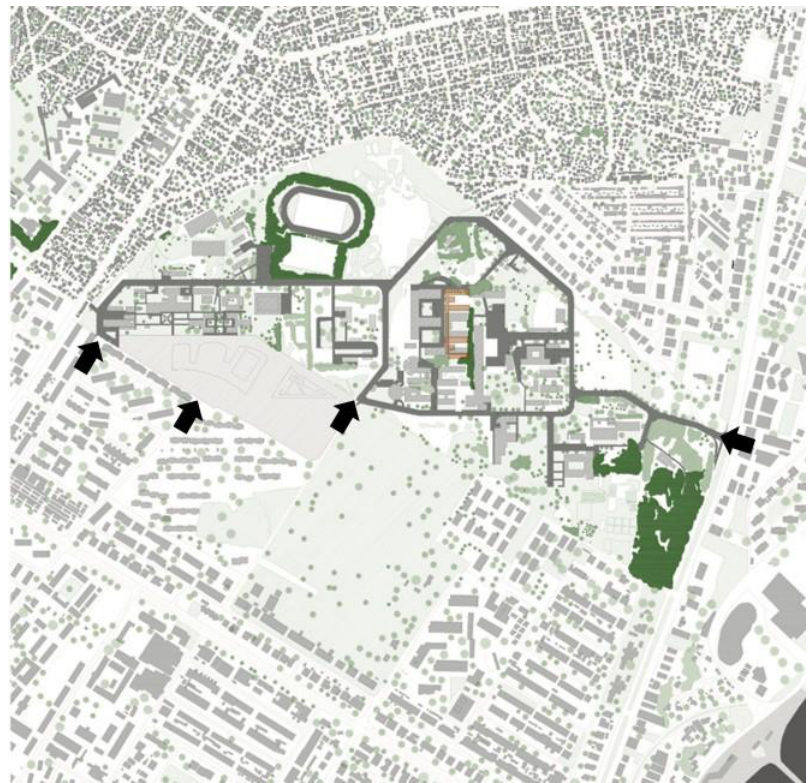
Figure 4. Current situation of the Campus. The four main entrances are signed with an arrow. In the north, the informal district with the typical steel-covered roof. On the right the coast with the line of recent skyscrapers. The green area is the botanical garden.